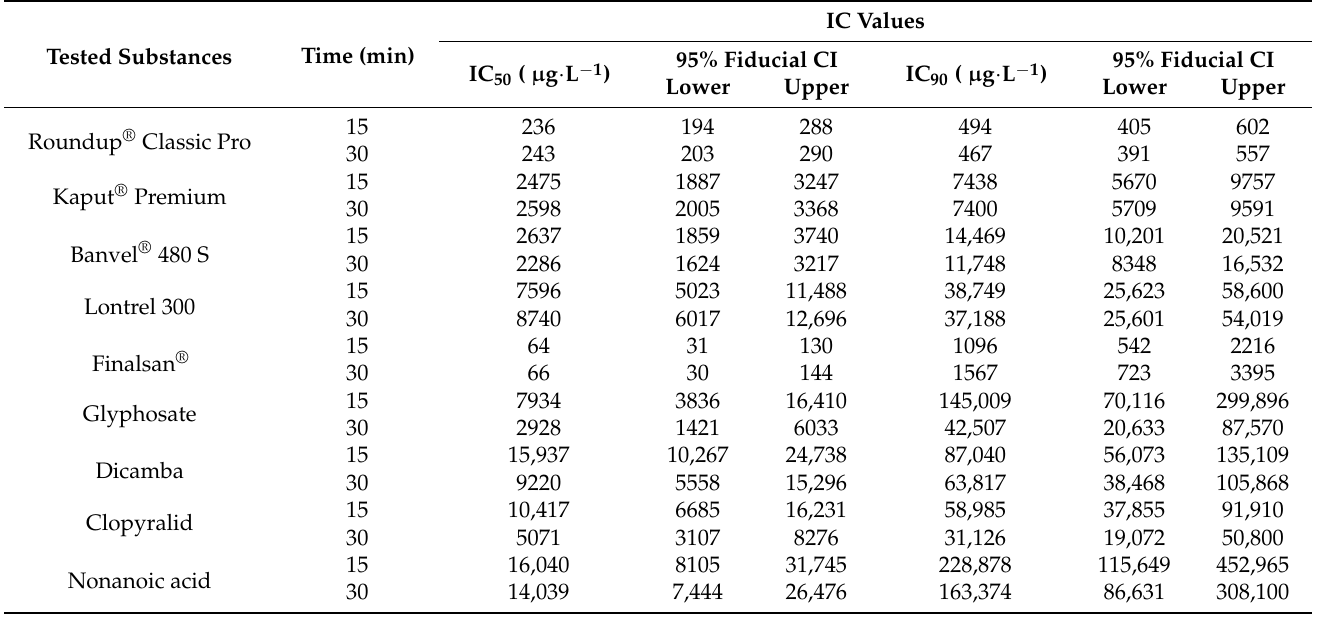
Table 1. IC 50 and IC 90 values of all tested herbicides and active substances, and 95% fiducial confidence intervals at 0.05 level of significance, tested organism A. fischeri